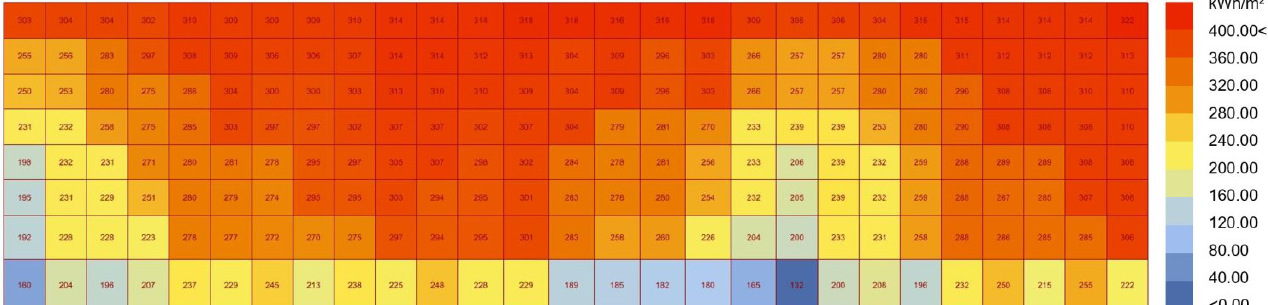
Figure 10. Year-round periodic radiation simulation based on window units.